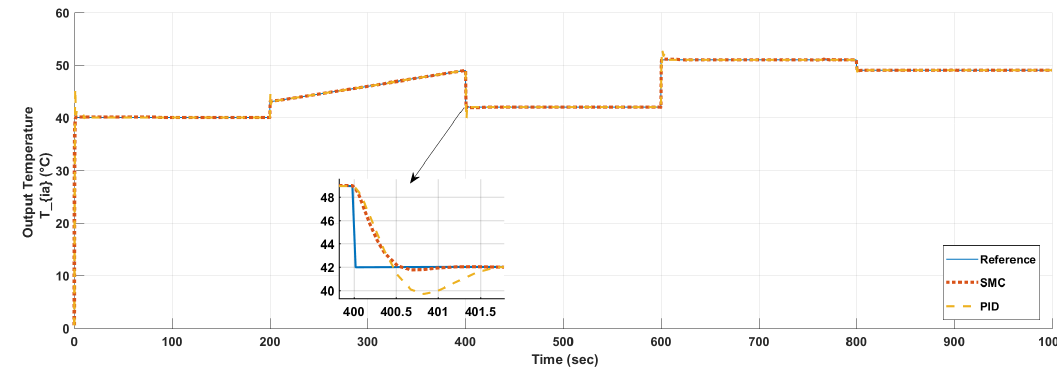
Figure 9. Output temperature response of controllers while tracking combination of sequence of steps and ramp reference.